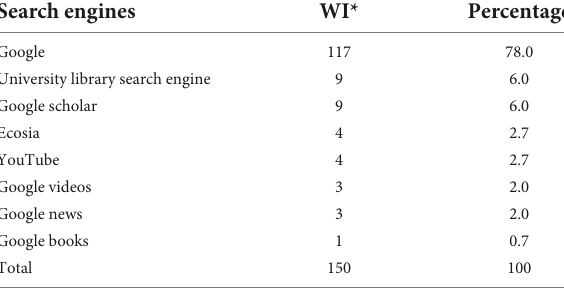
TABLE 1 Frequencies of used search engine types.